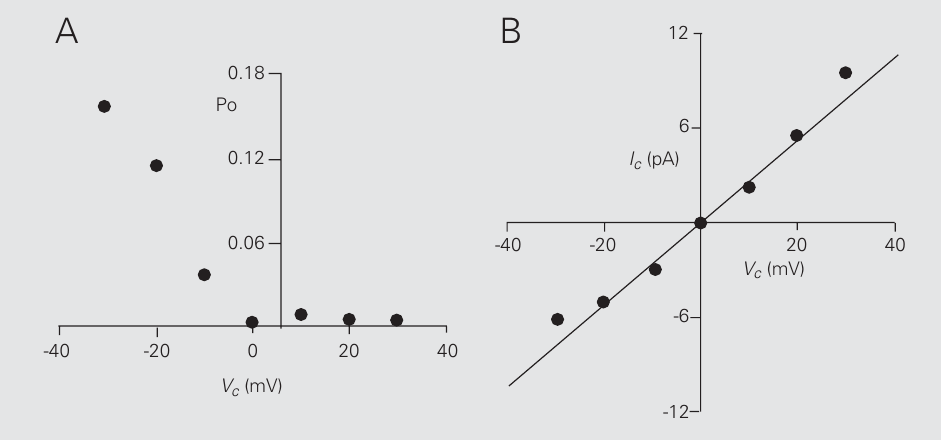
Figure 2. A , An example of the effect of V c on the open prob- ability (Po) in asymmetrical solu- tions for sodium and